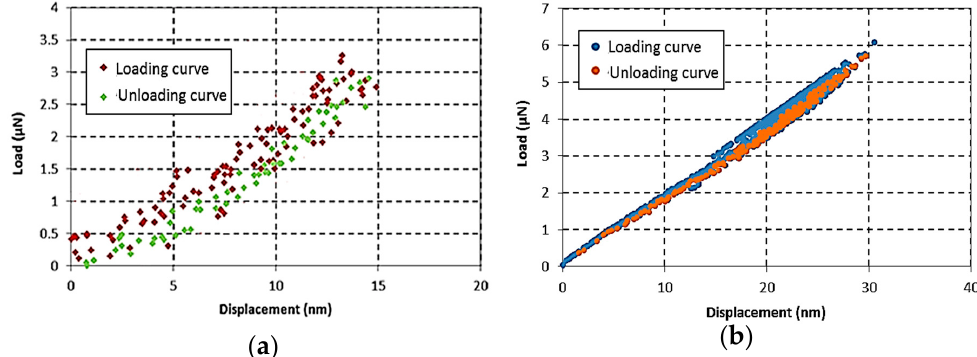
Figure 5. The loading-unloading responses of Bis-GMA polymer in the nano-indentation test (indentation loads of 3 μ N ( a ) and 6 μ N ( b )).